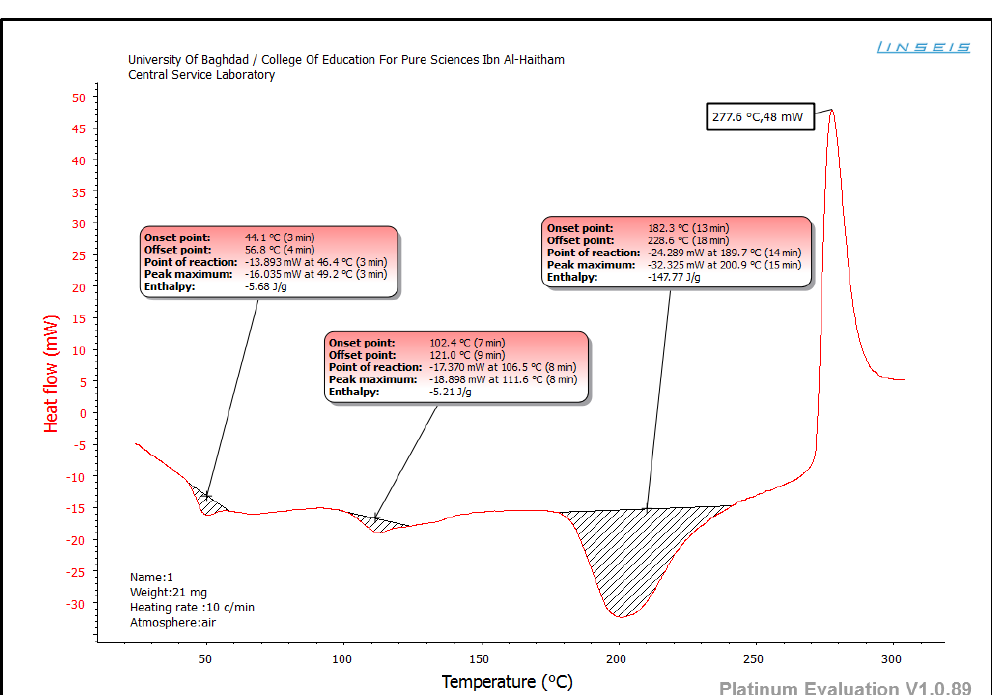
Figure9. DSC thermogram of lyophilized